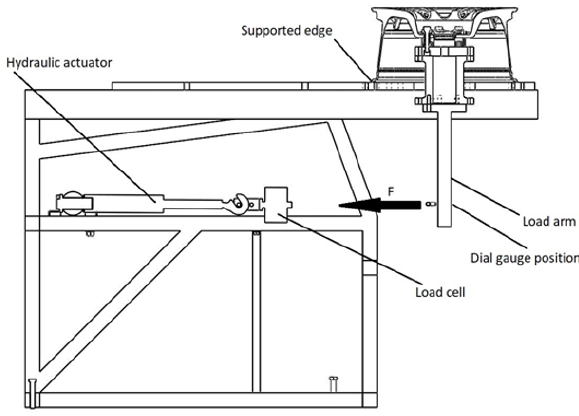
Figure 4: Cross-sectional schematic of the apparatus used